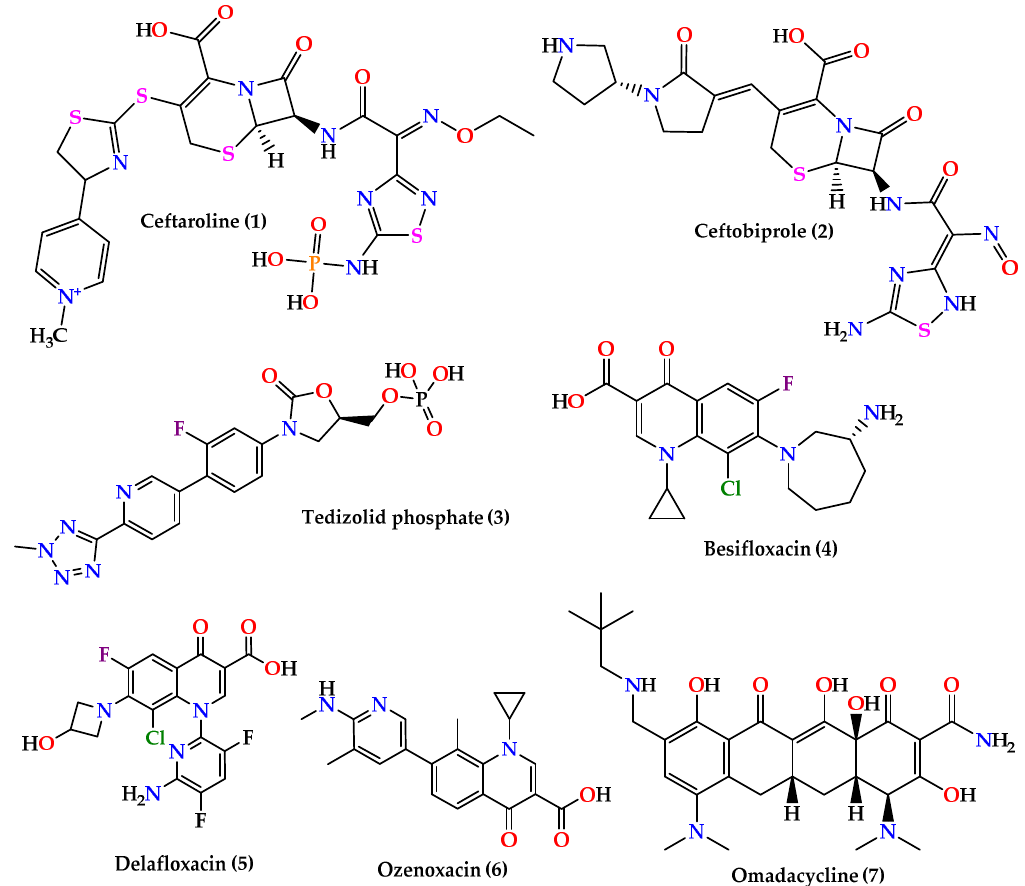
Figure 3. Chemical structures of ceftaroline (1), ceftobiprole (2), tedizolid phosphate (3),besifloxacin (4), delafloxacin (5),ozenoxacin (6), and omadacycline (7).